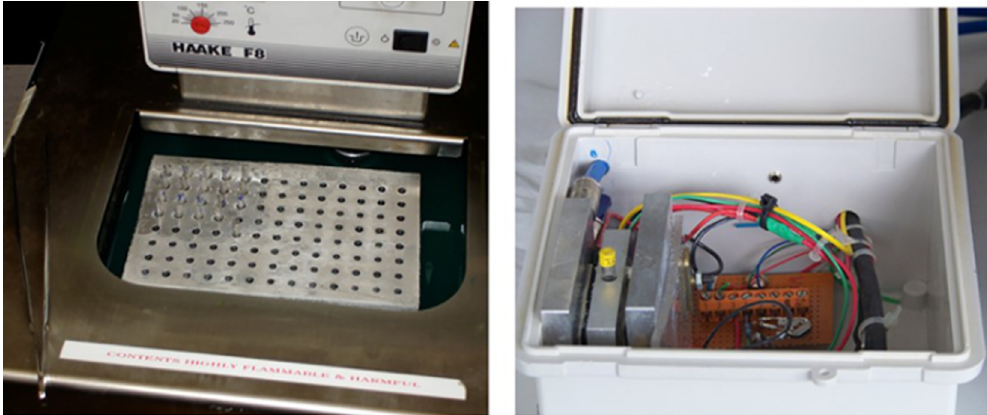
Fig 1. (Left) Metal rack holding the sample tubes, partly immersed in the ethanol bath of a refrigerated circulator. (Right) Sample chamber of the optical recrystallometer apparatus used for measuring RI